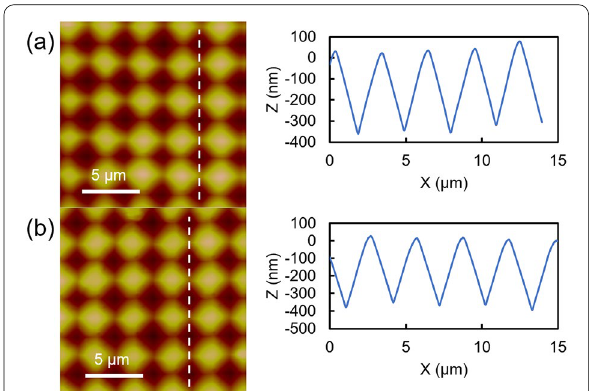
Figure 23 AFM images and the corresponding cross-sections of the nanostructures obtained with the rotation angle of 0° and the spacing of 3 μm ( a ) before and ( b ) after Au film deposition